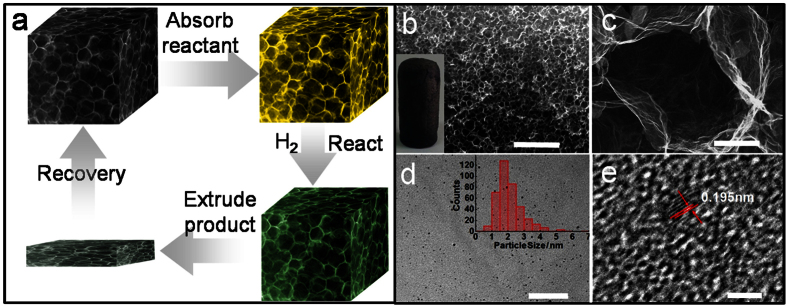
Scheme for the catalytic hydrogenation in Pd/GA and characterizations for Pd/GA-3.(a) The illustration of catalytic hydrogenation using GA as a reactor. (b) SEM image of the Pd/GA, the inset shows the photograph of the Pd/GA monolith with an integral structure. (c) Magnified SEM image of cell structure in Pd/GA. (d) TEM image of graphene sheet of the wall bearing Pd nanoparticles. The inset shows the size distribution of Pd nanoparticles. (e) HRTEM image of Pd/GA reveals the lattice spacing of about 0.195 nm, corresponding to the lattice fringe of Pd (2 0 0). Scale bars, 100 μm (b), 3 μm (c), 20 nm (d), and 2 nm (e), respectively.